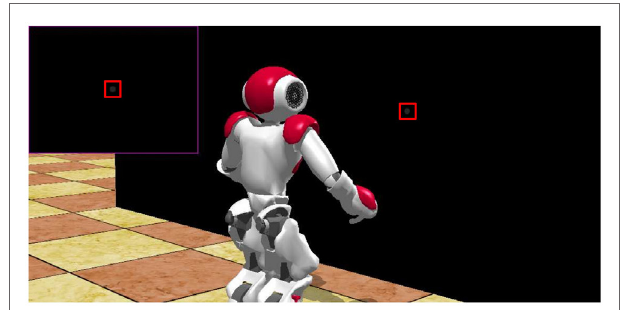
FigUre 4 | experimental setup